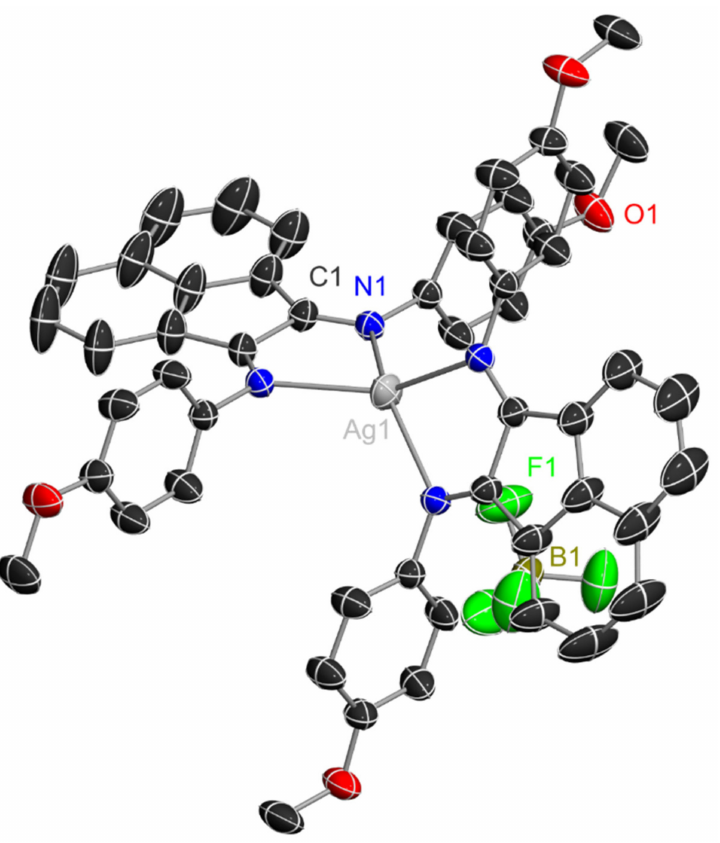
Figure 1. Solid-state molecular structure of Ag(I) bis-BIAN complex Ag4 in the crystal ( Ccca ). Thermal ellipsoids are drawn at the 30% probability level at 25 ◦ C. Hydrogen atoms are omitted for